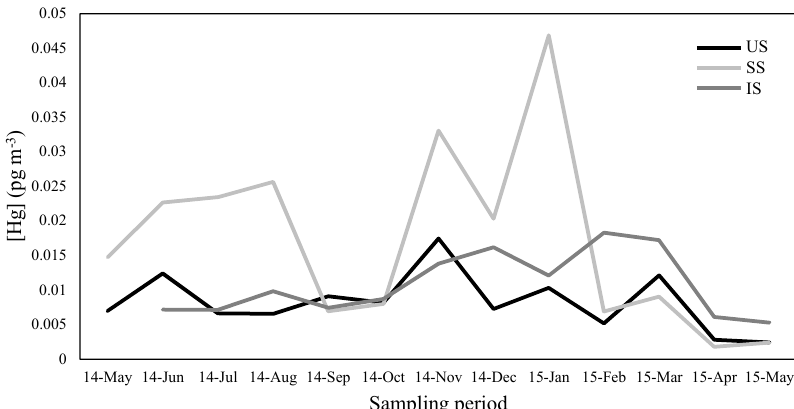
Figure 2. Monthly variation of PHg concentration during the study period at urban (US), suburban (SS) and industrial (IS) sites. Table 2. Analysis of variance of PHg concentration for winter and summer seasons at urban (US), suburban (SS) and industrial (IS) sites.